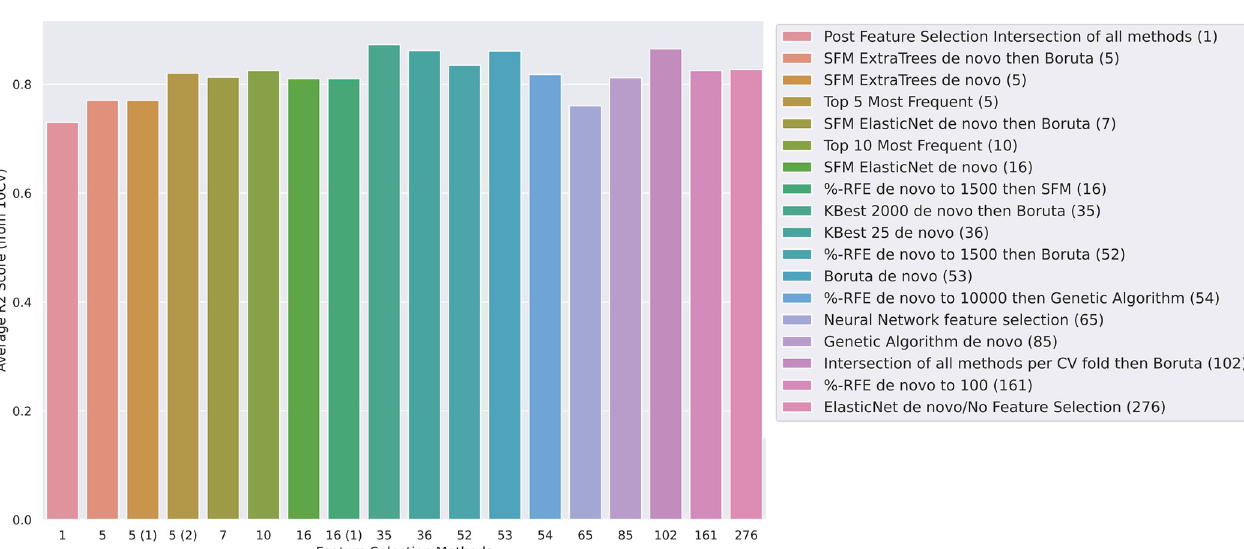
novo to 1500 then Boruta , which had an R2 of 0.835. Boruta de novo and KBest 25 de novo